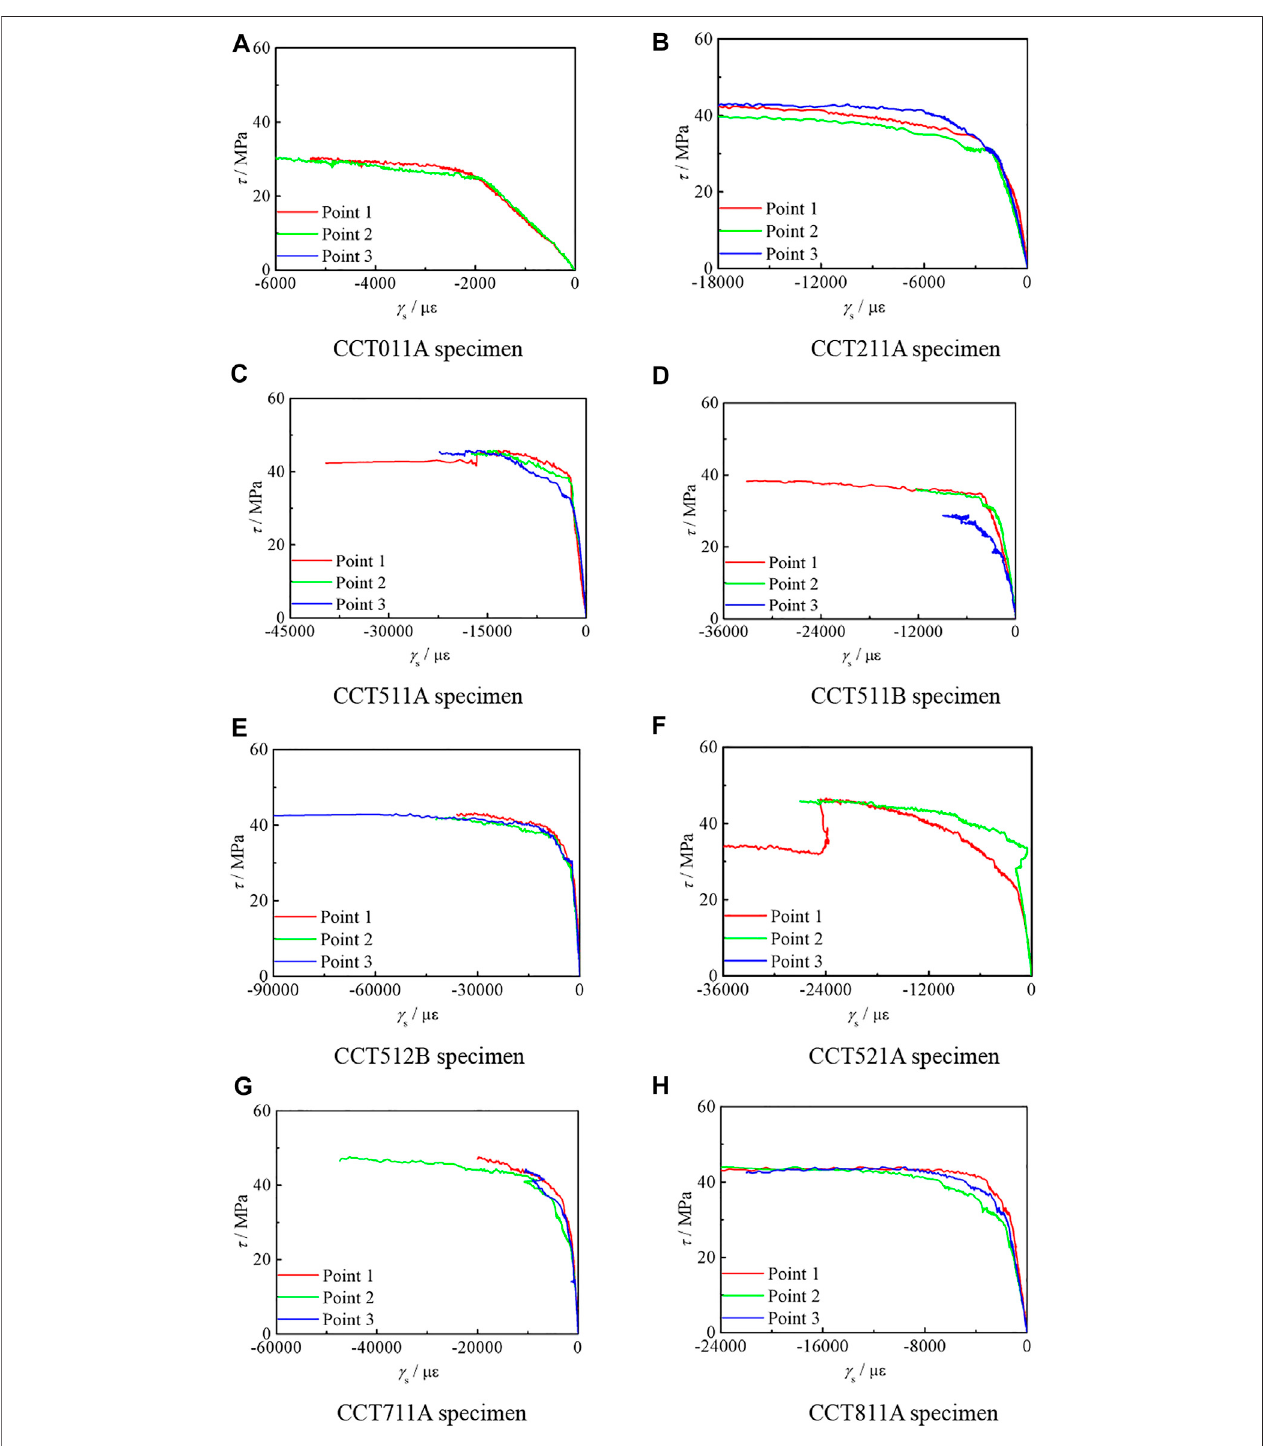
FIGURE 7 | τ – γ curve of the C-CF-CFRP-ST specimen. (A – H) Strain gauges at different locations.